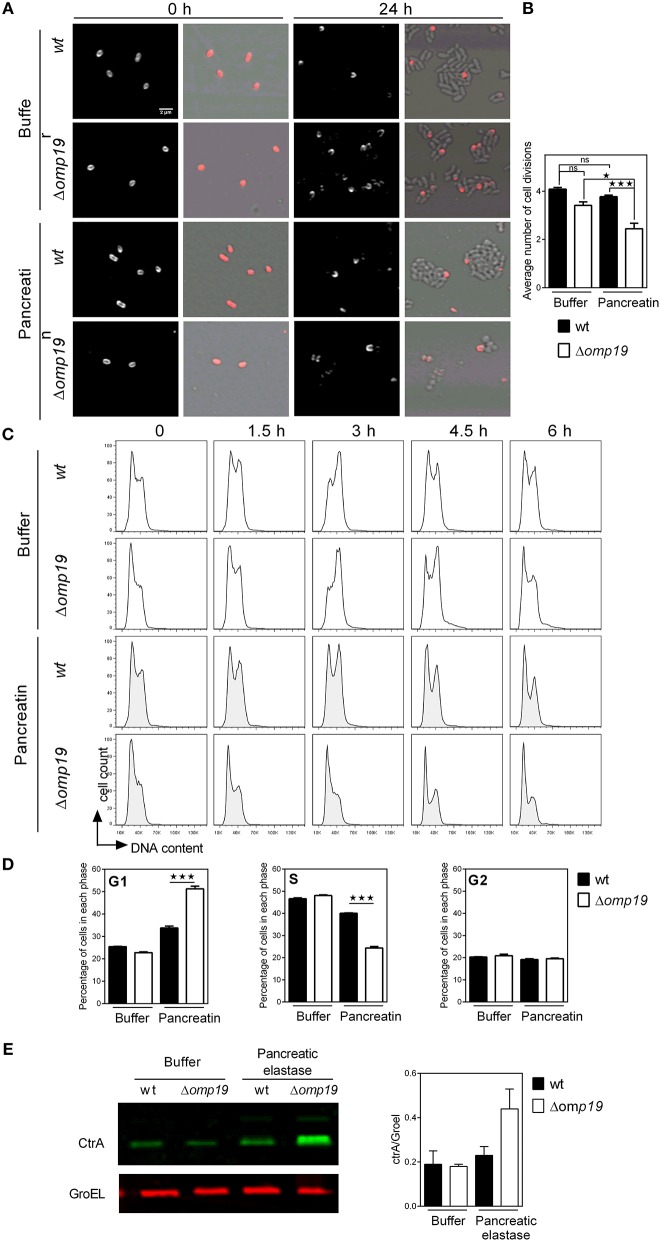
Δomp19 B. abortus has a cell division defect and cell cycle arrest upon incubation with pancreatic proteases. TRSE-labeled wt and Δomp19 B. abortus were dropped on TSB-agarose pads containing buffer or pancreatin and cultured for 24 h at 37°C. (A) Representative Texas Red fluorescence (left) and phase contrast microscopy images (right) from the beginning of incubation (0 h) and after 24 h of incubation are shown. (B) Average number of cell divisions after 24 h of culture obtained by quantification of the number of labeled (or partially labeled) cells and unlabeled cells in each individual colony (*p < 0.05 and ***p < 0.001 vs. wt B. abortus strain in pancreatin). Results are representative of two independent experiments. (C) Flow cytometry analysis of DNA content on individual bacteria. wt and Δomp19 B. abortus were incubated in buffer or pancreatin for the indicated time periods and the content of DNA was evaluated by Flow cytometry. Representative histograms are shown. Results are representative of two independent experiments. (D) Bar graphs indicate the percentage of cells in each phase of cell cycle after 3 h of culture. (***p < 0.001 vs. wt B. abortus strain in pancreatin). (E)
B. abortus wt and Δomp19 strains were incubated with buffer or pancreatic elastase. Equal quantities of bacteria were subjected to SDS-page followed by western blot analysis using specific antibodies for CtrA and GroEL. Images are representative of two independent experiments. The ratio of CtrA and GroEL signals was evaluated by quantitative analysis of western blot images. Bar graph represent the mean ± s.e.m. of pooled results from two independent experiments.